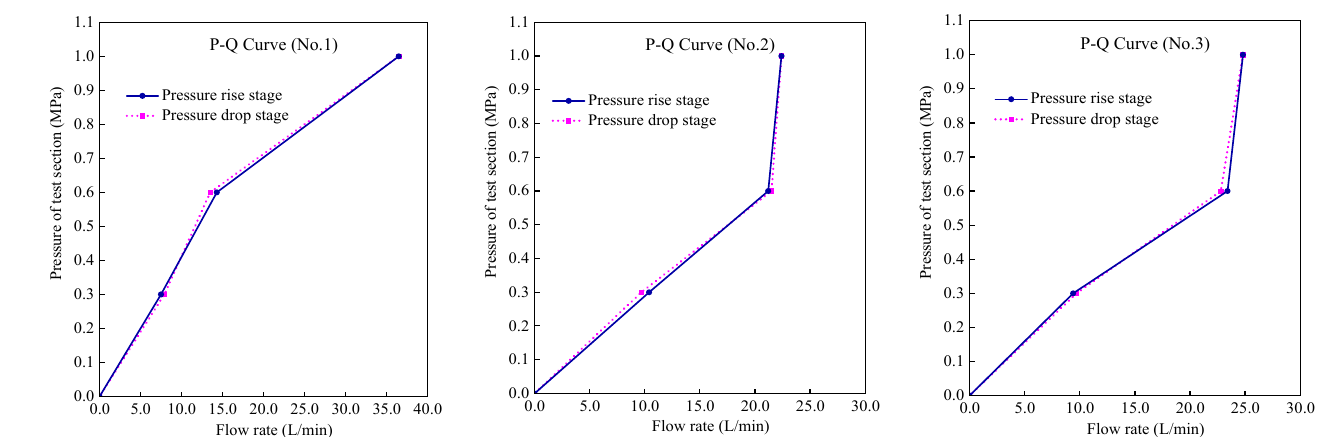
Figure 5. Three groups water pressure 𝑃 − 𝑄 curves. However, the flow rate of the fourth phase and the second phase, and the fifth phase and the first phase basically coincide, indicating that this fracture status change is temporary and reversible. With the decrease in test pressure, the fracture returns to its original status, which showing an elastic expansion property. The 𝑃 − 𝑄 curves of the second and third groups water pressure tests belong to the turbulent flow type ( 𝐵 type), Table 3. The water permeability of the corresponding test section in three group and the pressure rise curve in the 𝑃 − 𝑄 curve is basically the curve of the convex to the 𝑄 axis. Similarly, the pressure drop curve and the pressure rise curve basically coincide. The fracture status has not changed during the whole test period.